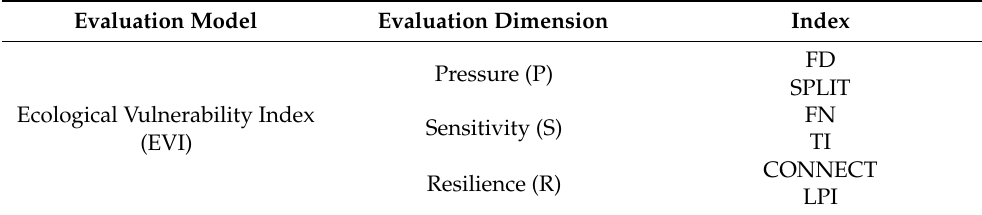
Table 3. Construction of ecological vulnerability assessment